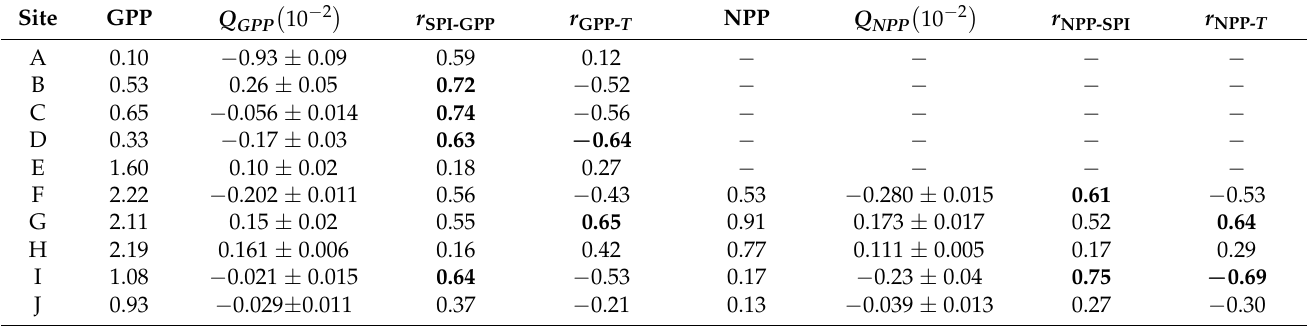
NPP. R > |0.6| in bold ( p -value < 0.05).